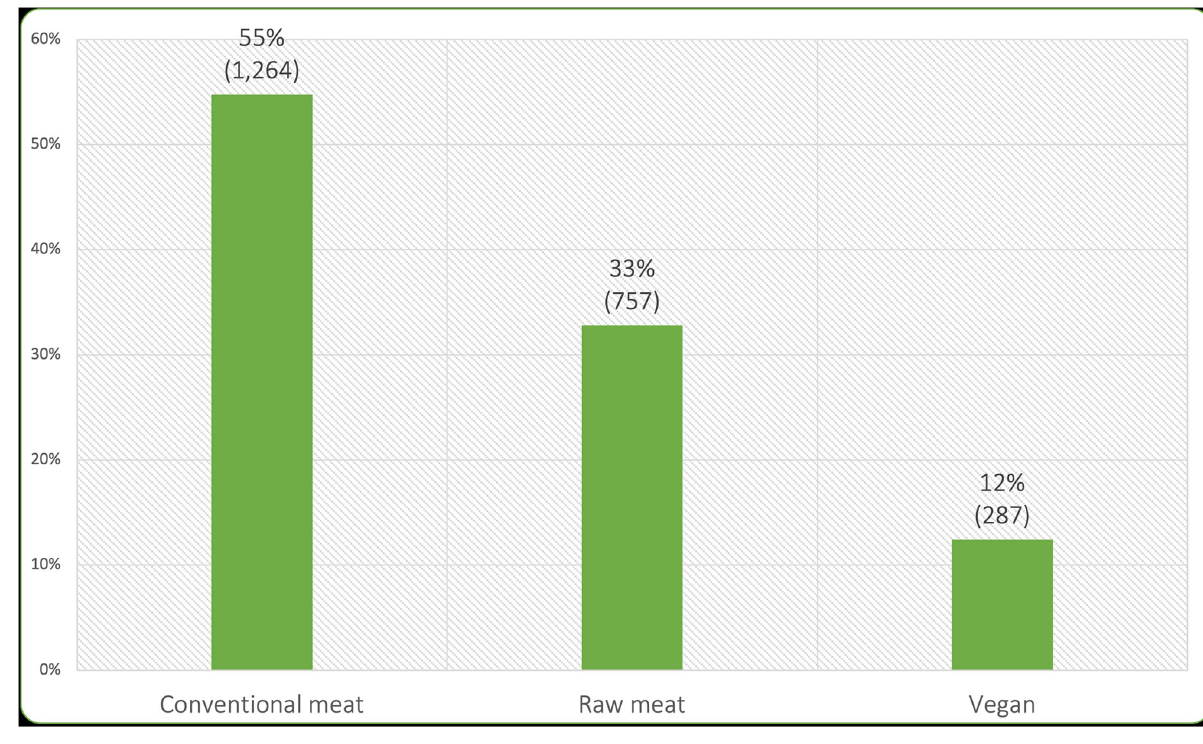
Fig 1. Diets of 2,308 sampled dogs.